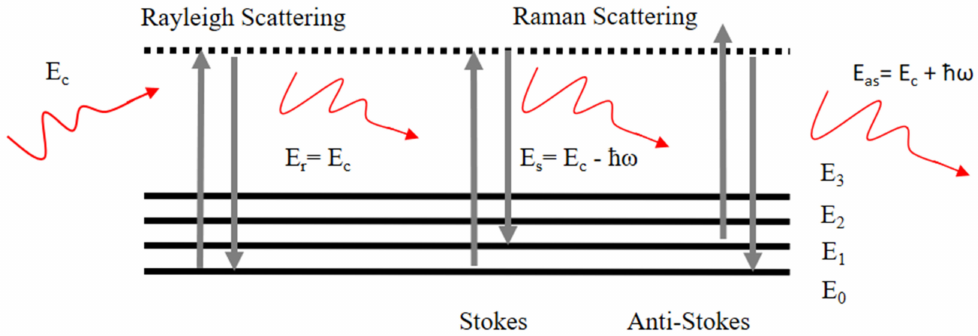
Figure 1. Schematics of energy levels of a molecule for Rayleigh and Raman Scattering